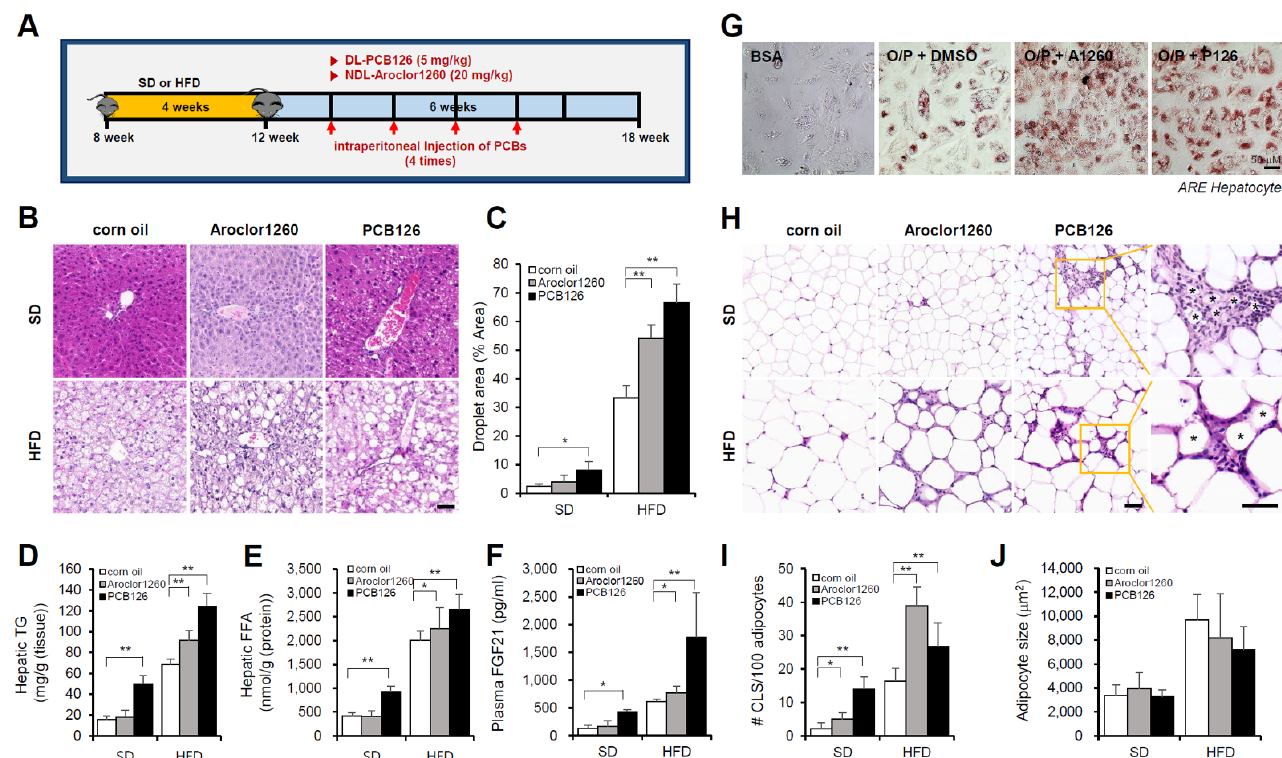
Figure 1. PCB exposure induces NAFLD/NASH in mice fed either a SD and a HFD. Eight-week-old male C57BL/6 mice were fed either a SD or HFD for four weeks and then treated with vehicle (corn oil), Aroclor1260 (20 mg/kg) or PCB126 (5 mg/kg) by intraperitoneal injection for a total of four injections (two, three, four, and five weeks) during the six-week study duration. ( A ) Experimental design. ( B ) Representative images of H&E staining of liver tissue. Scale bar: 50 µ m. ( C ) Quantification of the lipid droplet area in H&E-stained liver tissue. The data are expressed as a percentage of the area of lipid droplets in the field. ( D ) Hepatic TG. ( E ) Hepatic FFA. ( F ) Plasma FGF21. ( G ) ORO staining showing that both Aroclor1260 (20 μ M) and PCB126 (10 μ M) accelerated hepatic lipid accumulation in O/P-treated human ARE primary hepatocytes. Scale bar: 50 μ m. ( H ) Representative images of H&E staining of adipose tissue. The crown-like structure is illustrated by the asterisk. Scale bar: 50 μ m. ( I ) Average adipocyte size of eWAT was measured in H&E images using ImageJ 1.53 s. ( J ) Quantitative analysis of CLS formation in adipose tissue. All values represent the mean ± SD, n = 7–10 mice per group. * p < 0.05 and ** p < 0.01.